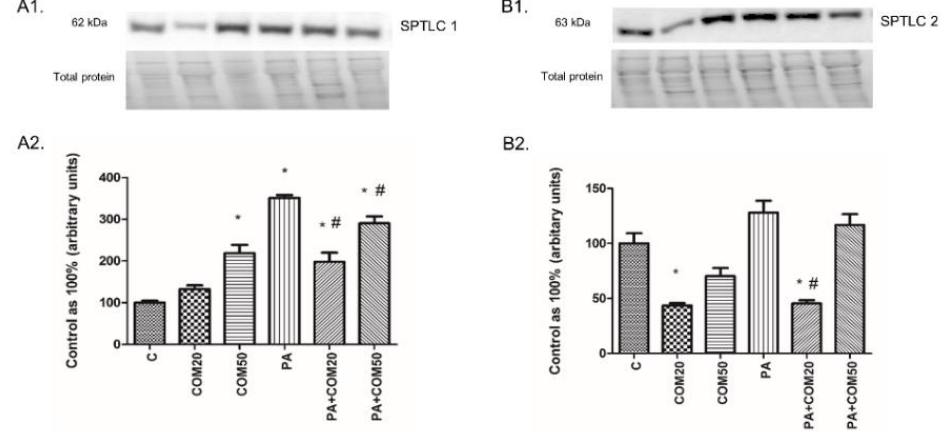
Figure 3. Representative Western blot membranes of evaluated proteins, i.e., SPTLC1—serine palmitoyl transferase 1 ( A1 ), SPTLC2—serine palmitoyl transferase 2 ( B1 ), and the corresponding images of total protein staining after membrane transfer used for normalization. The expression of enzymes involved in ceramide de novo synthesis pathway, i.e., SPTLC1 ( A2 ) and SPTLC2 ( B2 ) in primary rat hepatocytes. The cells were incubated with presence or absence of PA (0.5 mM) or/and COM (20 or 50 µ M), as it was described in Materials and Methods section. The protein expression was evaluated by the Western blot technique. The data are shown as the mean ± SD and are based on six independent determinations ( n = 6); * p < 0.05 significant difference vs. control group; # p < 0.05 significant difference vs. palmitate group; C, control; COM20 or COM50, coumestrol 20 or 50 µ M; PA, palmitic acid; PA + COM20 or PA + COM50, palmitic acid + coumestrol 20 or 50 μM.